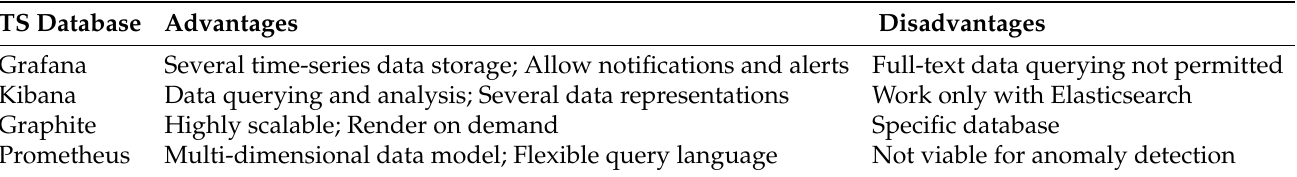
Table 5. Time-series databases